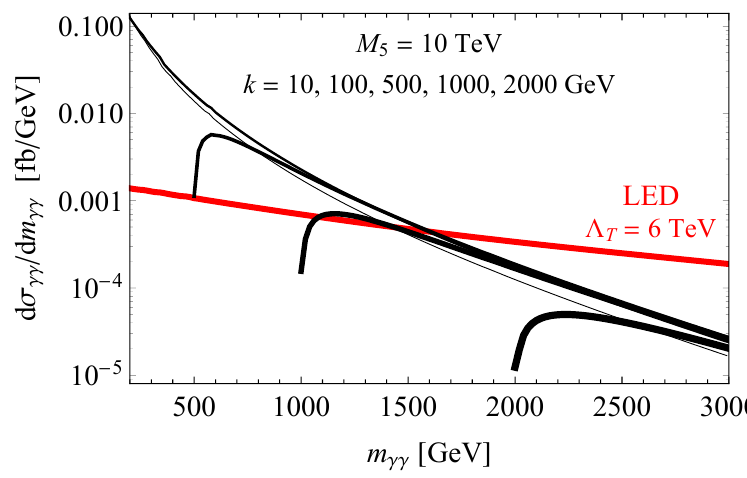
Figure 10 . Cross section of the diphoton signal at the 13 TeV LHC for k = 2000, 1000, 500, 100, 10 GeV (from thickest to thinnest) and M 5 = 10 TeV. Also shown (in red) is the signal from LED with > 2 extra dimensions with (cid:3) T = 6 TeV. In the k = 10 GeV case, the signal is reduced because of the diphoton branching ratio suppression due to signi(cid:12)cant decay rates into lighter KK gravitons. m > 400, 500, 700, 900, 1200, 1800, 3000 GeV, summing the electron and muon events. ‘‘ For each point in the parameter space the search region with the best expected limit